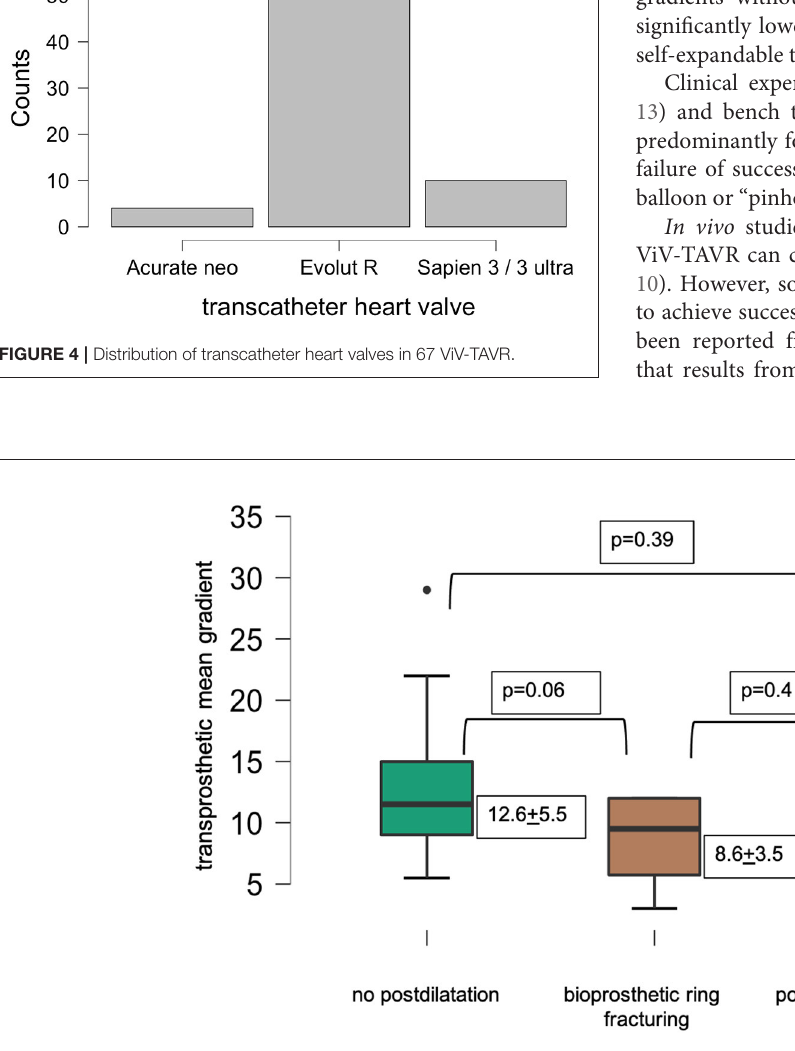
Frontiers in Cardiovascular Medicine |